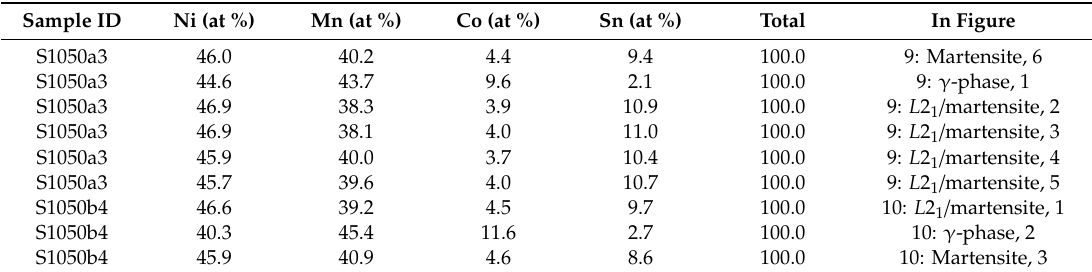
Table 6. Composition of regions in the microstructures of the S1050a3 and